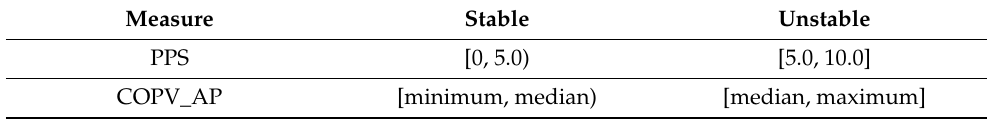
Table 3. Data labeling criteria based on PPS 1 and COPV_AP 2 values. Measure